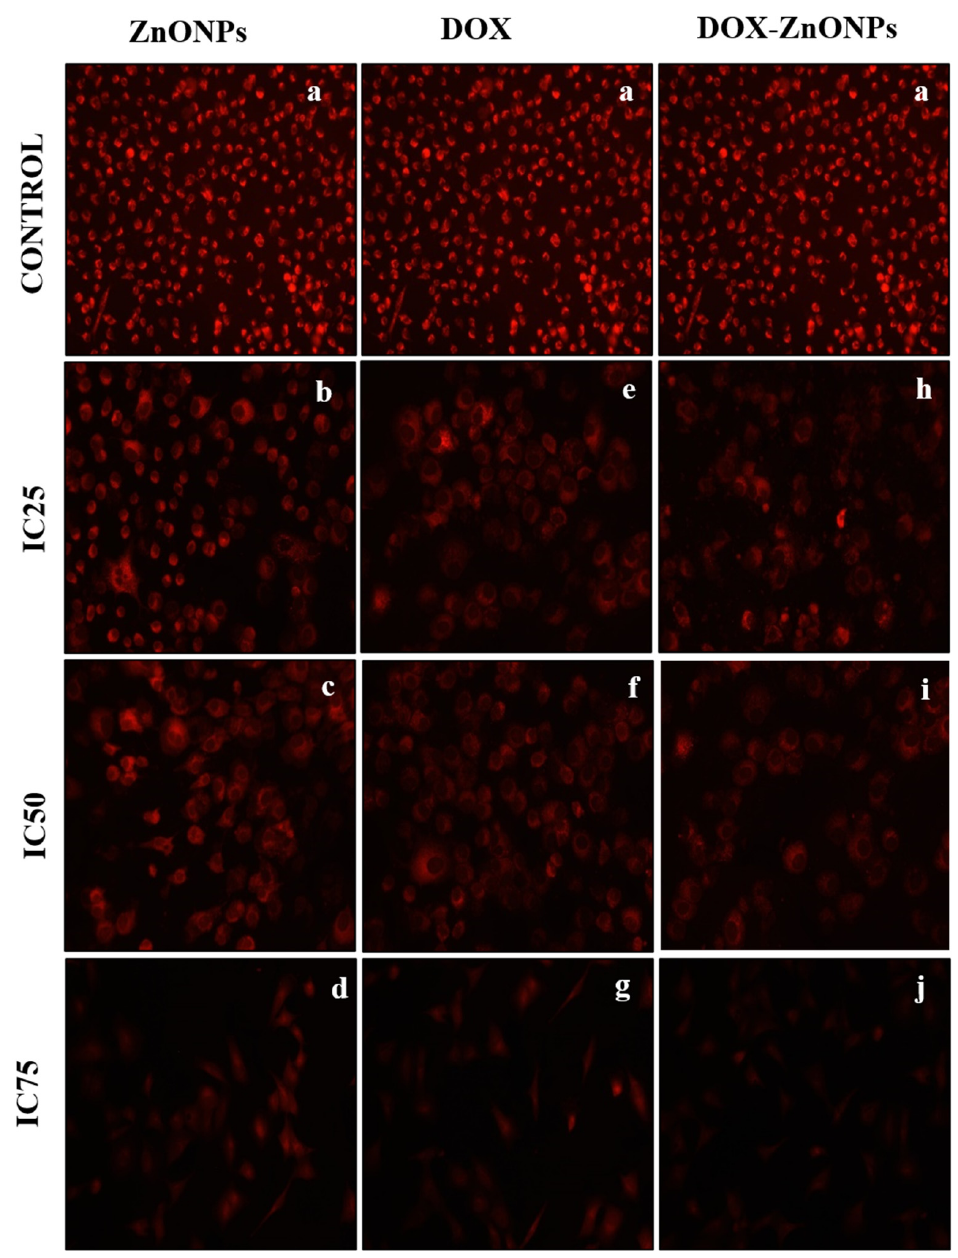
Figure 9. Images showing Mitotracker Red CMX ROS staining of A549 cells treated at IC25 [( b ) ZnONPs 27.83 µ g/mL; ( e ) DOX 0.27 µ g/mL; ( h ) DOX-ZnONPs 0.079 µ g/mL], IC50 [( c ) ZnONPs 65.3 µ g/mL; ( f ) DOX 0.56 µ g/mL; ( i ) DOX-ZnONPs 0.34 µ g/mL] and IC75 [( d ) ZnONPs 70.41 µ g/mL; ( g ) DOX 0.72 µ g/mL; ( j ) DOX-ZnONPs 0.69 µ g/mL] concentrations. Vehicle control group image is shown as ( a ). Images shown are representative of three independent